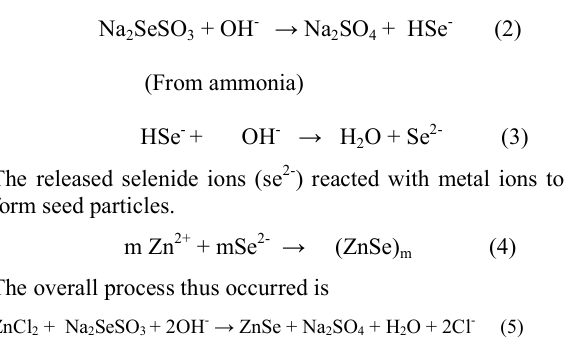
Figure1 : PVA Capping around ZnSe nanoparticles.